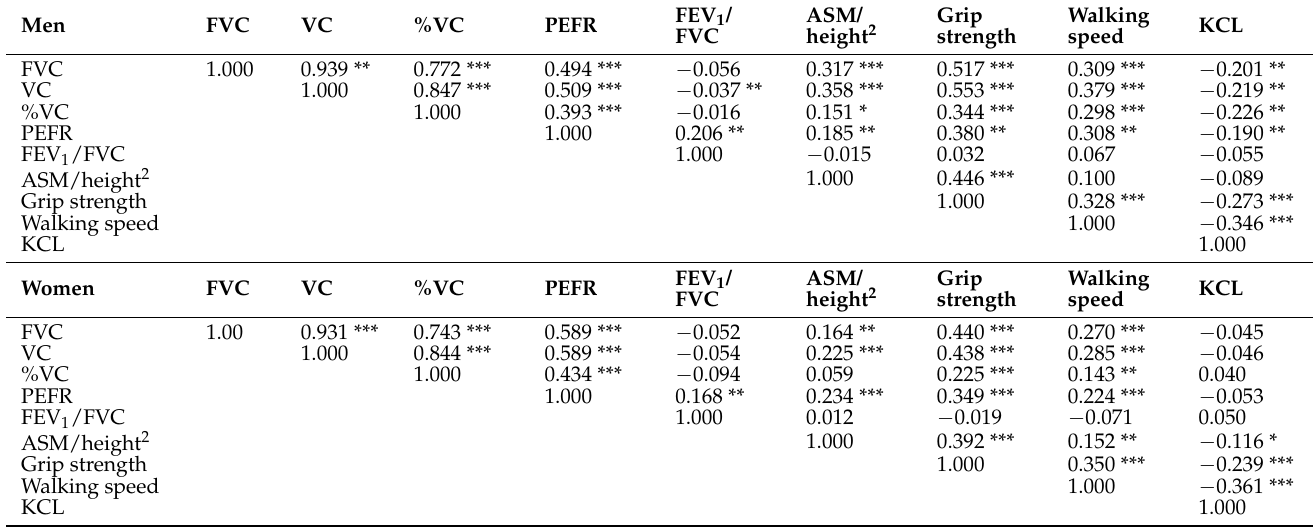
Table 2. Pearson’s correlation coefficient between respiratory function, physical performance, and Kihon checklist points.